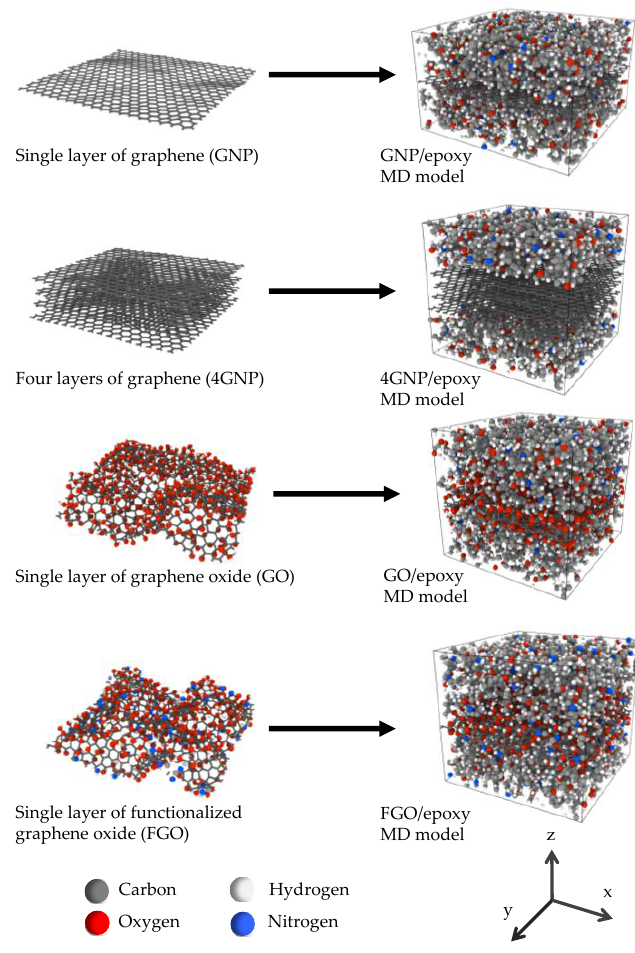
Figure 1. Representative MD models of GNP, 4GNP, GO, and FGO nanoplatelets and their corre- sponding nanoplatelet/epoxy MD models.